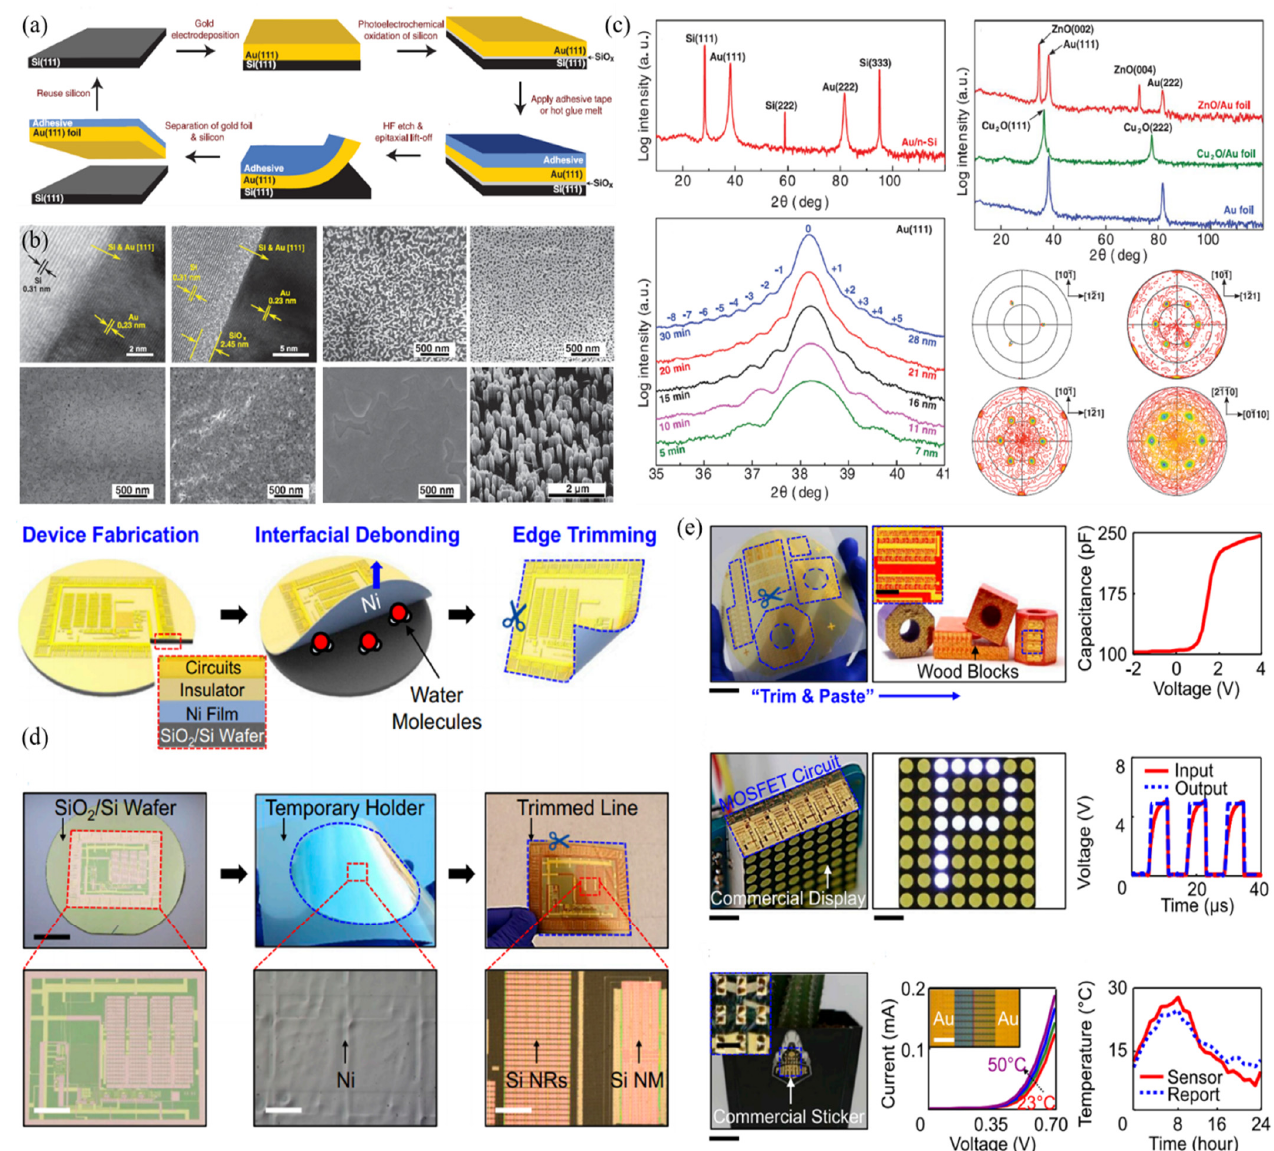
Figure 8. The high-quality thin film is obtained by the debonding method for flexible electronics. ( a ) The schematic diagram for the epitaxial lift-off of single-crystal Au foil by the release of SiO 2 layer [189]. ( b ) Comparison for the high-resolution TEM studies of the epitaxial grown and transferred Au film with the application of Cu 2 O and ZnO growth [189]. ( c ) In-plane and out-of-plane orientation studies by the X-ray diffraction and pole figure for the transferred Au foil [189]. ( d ) Schematic illustration of the thin-film transfer for large-area nanoelectronics based on the SiO 2 layer releasable method [190]. ( e ) Device fabrication on the transferred thin film and its performance characterizations [190]. Reprinted with permission from ref. [189]. Copyright 2017 American Association for the Advancement of Science. Reprinted with permission from ref. [190]. Copyright 20118 United States National Academy of Sciences.